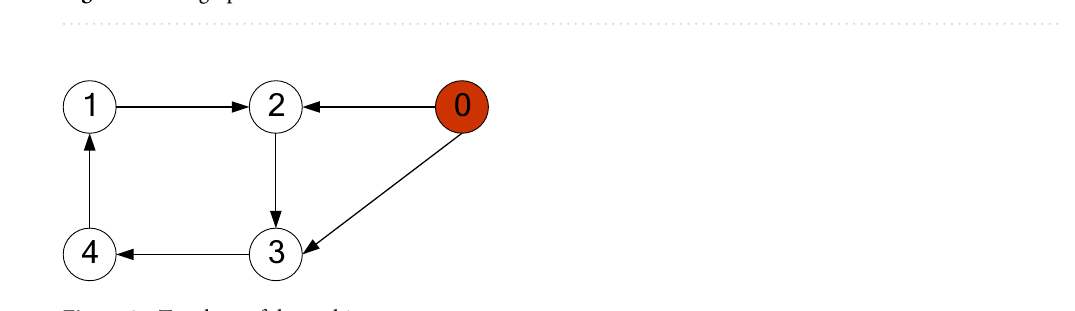
Figure 2. Design procedure.